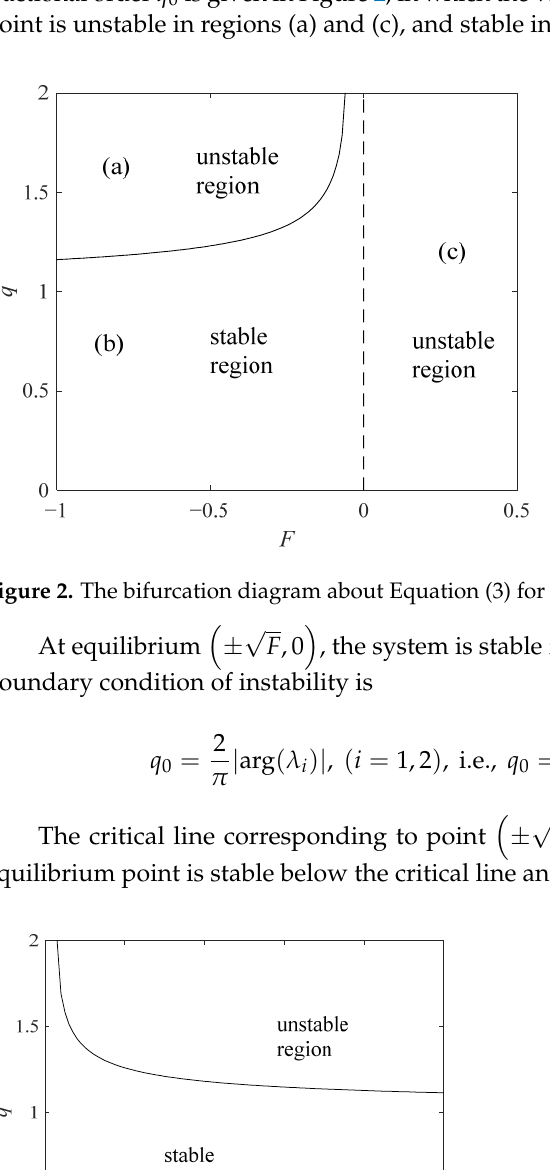
Figure 3. The bifurcation diagram about Equation (3) for equilibrium